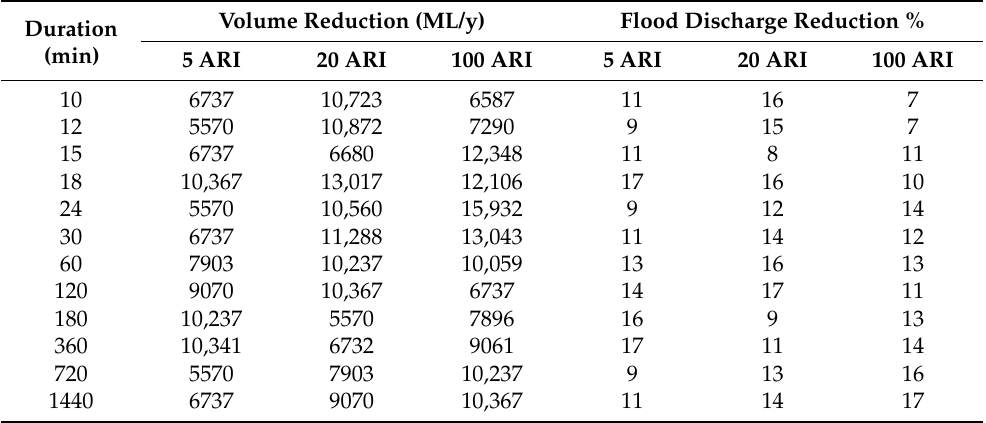
Table 3. Percentage reduction of flood discharge with the application of permeable pavements for the range of storm durations and average recurrence